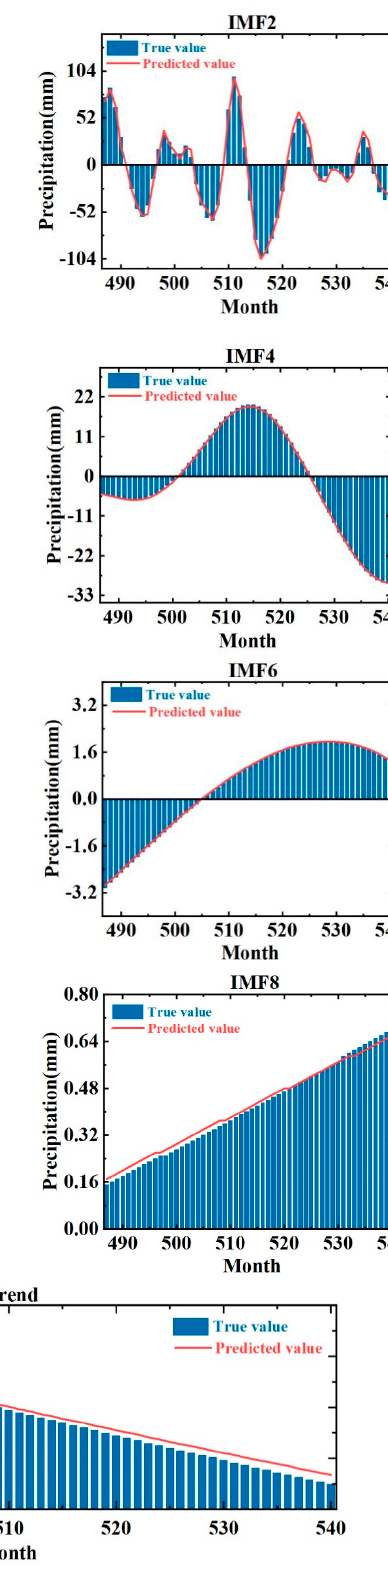
Table 4. Mean relative error of IMF1-8.